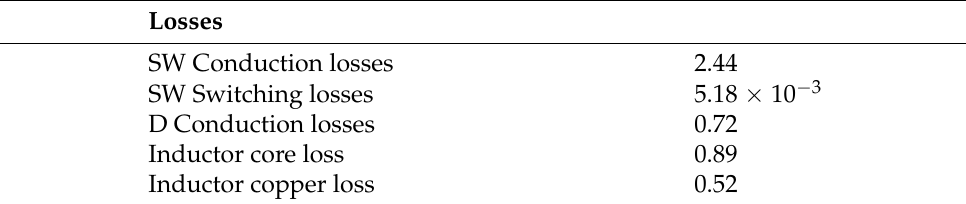
Table 5. The Power loss of the BBSM